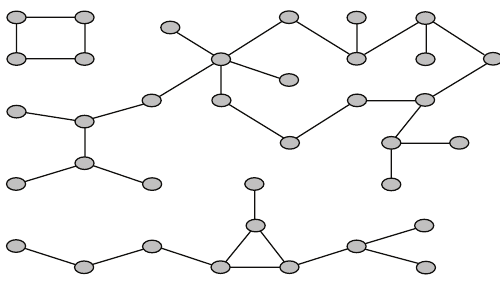
Figure 4: Three connected components in a